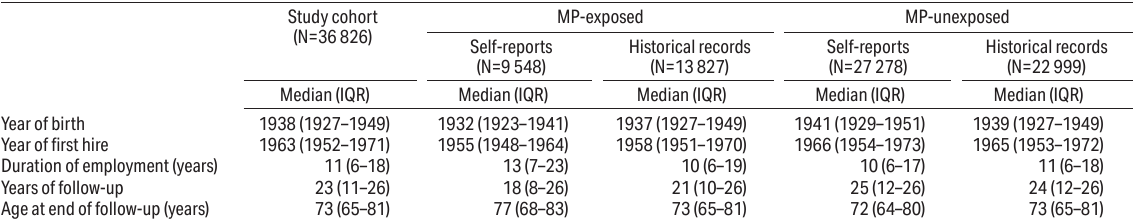
Table 1. Characteristics of workers in the study cohort and workers with ever and never exposure to McIntyre Powder (MP), described by median and interquartile range. [N=number of workers; IQR=interquartile